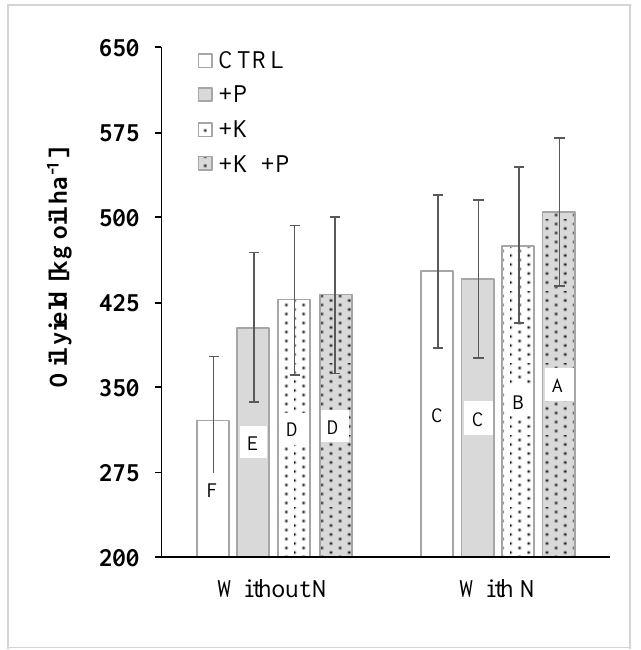
Figure 6. Least squares means (LSmeans) and standard error estimate of the LSmeans of the oil yield number of pods per unit area in Oenothera biennis L. local genotype (Evening Primrose) and Brassica napus L cv. serw 1 (Rapeseed) grown in 2 growing seasons in a P and K deficient soil and fertilized with 142.9 kg N ha −1 , 171.4 kg K 2 O ha −1 , or 36.9 kg P 2 O 5 ha −1 . Data are means of the species. Means with a letter in common cannot be considered different according to a conservative Tukey-grouping applied to the p differences of the LSmeans. N = 12. Please note that error bars are standard error estimates of the LSmeans and not the computed standard error, which can be found in Supplementary Materials Table S1. CTRL indicates a lack of P and K applications.